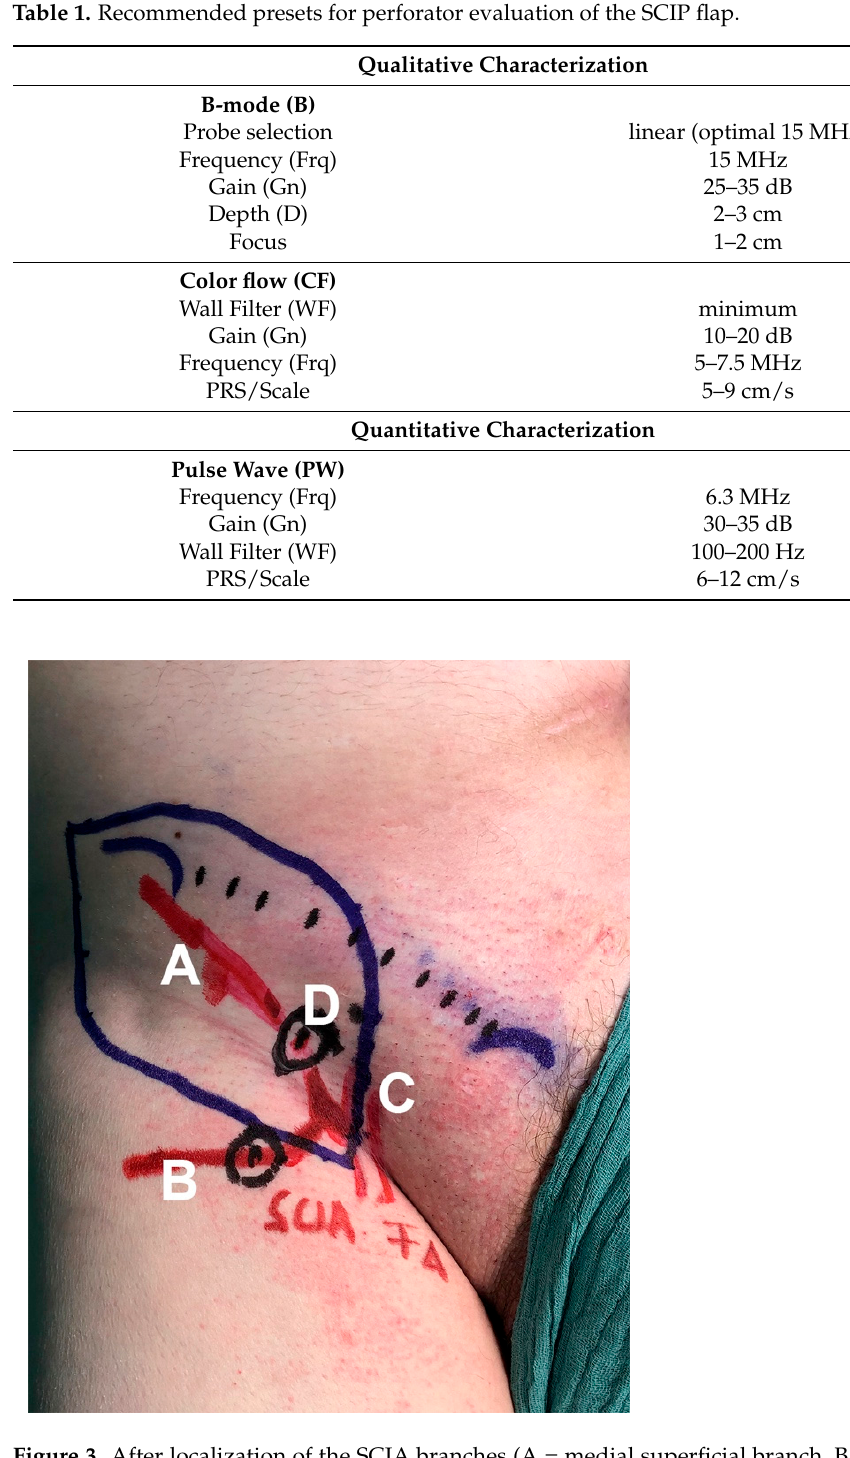
Figure 3. After localization of the SCIA branches (A = medial superficial branch, B = lateral deep branch), the femoral artery (C) and the emergence point, where the medial superficial branch perforates the deep and superficial fascia (D); these findings were marked individually with a pen .